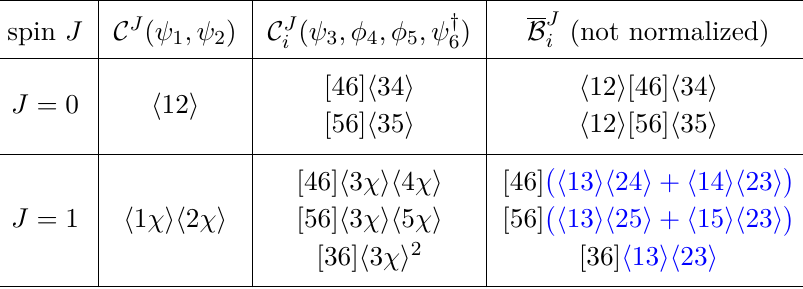
Table 4 . Partial-wave basis of process M ( ψ 1 ψ 2 | ψ 3 φ 4 φ 5 ψ † bridge structure which has totally symmetric contractions. Note that for more than two particles, C J have degeneracy labeled by a subscript, and so does the resulting partial waves. We are not providing a complete list of partial waves here, because there can be inequivalent C J with more spinor